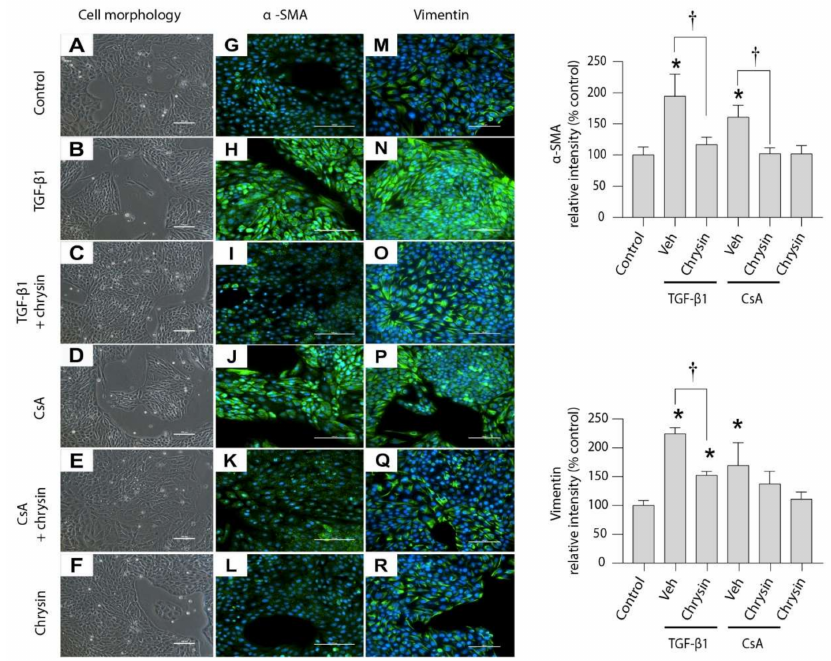
Figure 4. Effect of chrysin on TGF- β 1- or CsA-induced EMT. LLC-PK 1 cells were treated for 48 h with 5 ng/mL TGF- β 1 or 4.2 µ M CsA in the absence of 25 µ M chrysin. Morphological changes ( A – F ) and immunofluorescence (green) of α -SMA ( G – L ) and vimentin ( M – R ) were assessed. Micrographs shown are representative of four individual experiments. For immunocytochemistry the nuclei were counterstained with DAPI (blue). The light micrographs were taken at a magnification of 200 × (scale bar = 100 µ m) and immunofluorescence micrographs were captured at a magnification of 400 × (scale bar = 100 µ m). Fluorescence for α -SMA and vimentin was quantified and data are represented as percent intensity relative to the control group. Statistical significance was determined by two-way ANOVA followed by Tukey’s multiple comparison test. * indicates p < 0.05 versus control; † indicates p < 0.05 versus chrysin